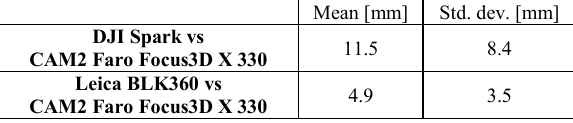
Table 8. Statistical synthesis of the cloud-to-cloud absolute